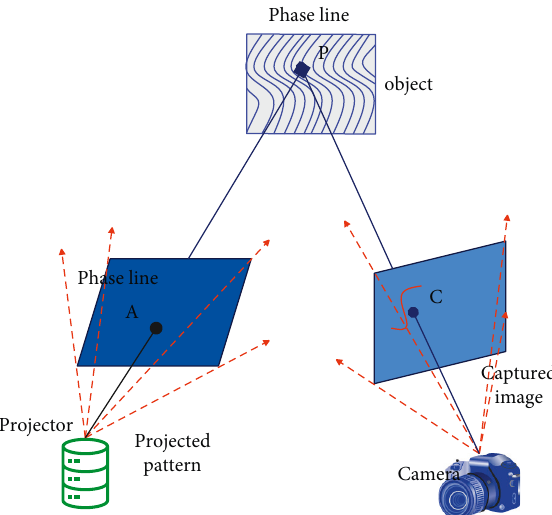
Figure 6: Schematic diagram of structured light